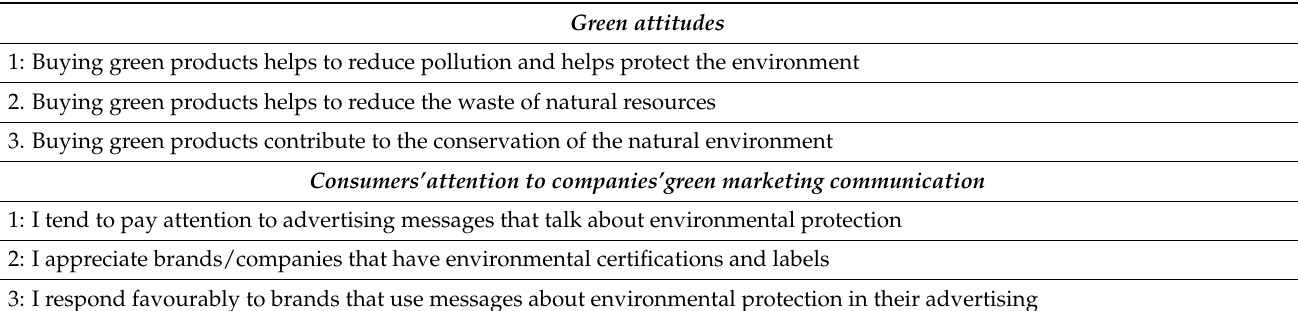
Table A1. Scales to assess consumers’ green attitudes, consumers’ attention to green marketing communication, and consumers’ green purchase